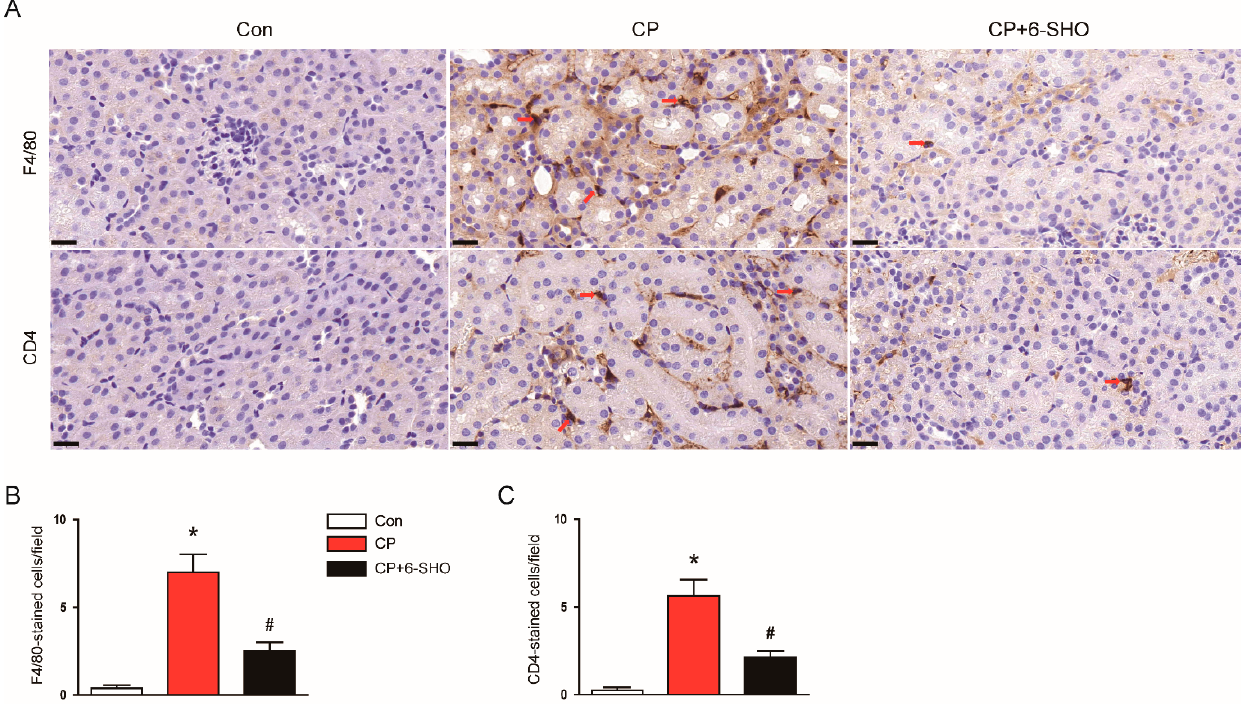
Figure 9. Effect of 6-shogaol on immune cell infiltration in cisplatin-treated mice. ( A ) Representative images of IHC staining for F4/80 and CD4. Red arrows indicate positively stained cells. Scale bar = 20 μ m. ( B ) Number of F4/80-stained cells per field. ( C ) Number of CD4-stained cells per field. n = 8 per group of mice. * p < 0.05 versus Con. # p < 0.05 versus CP.